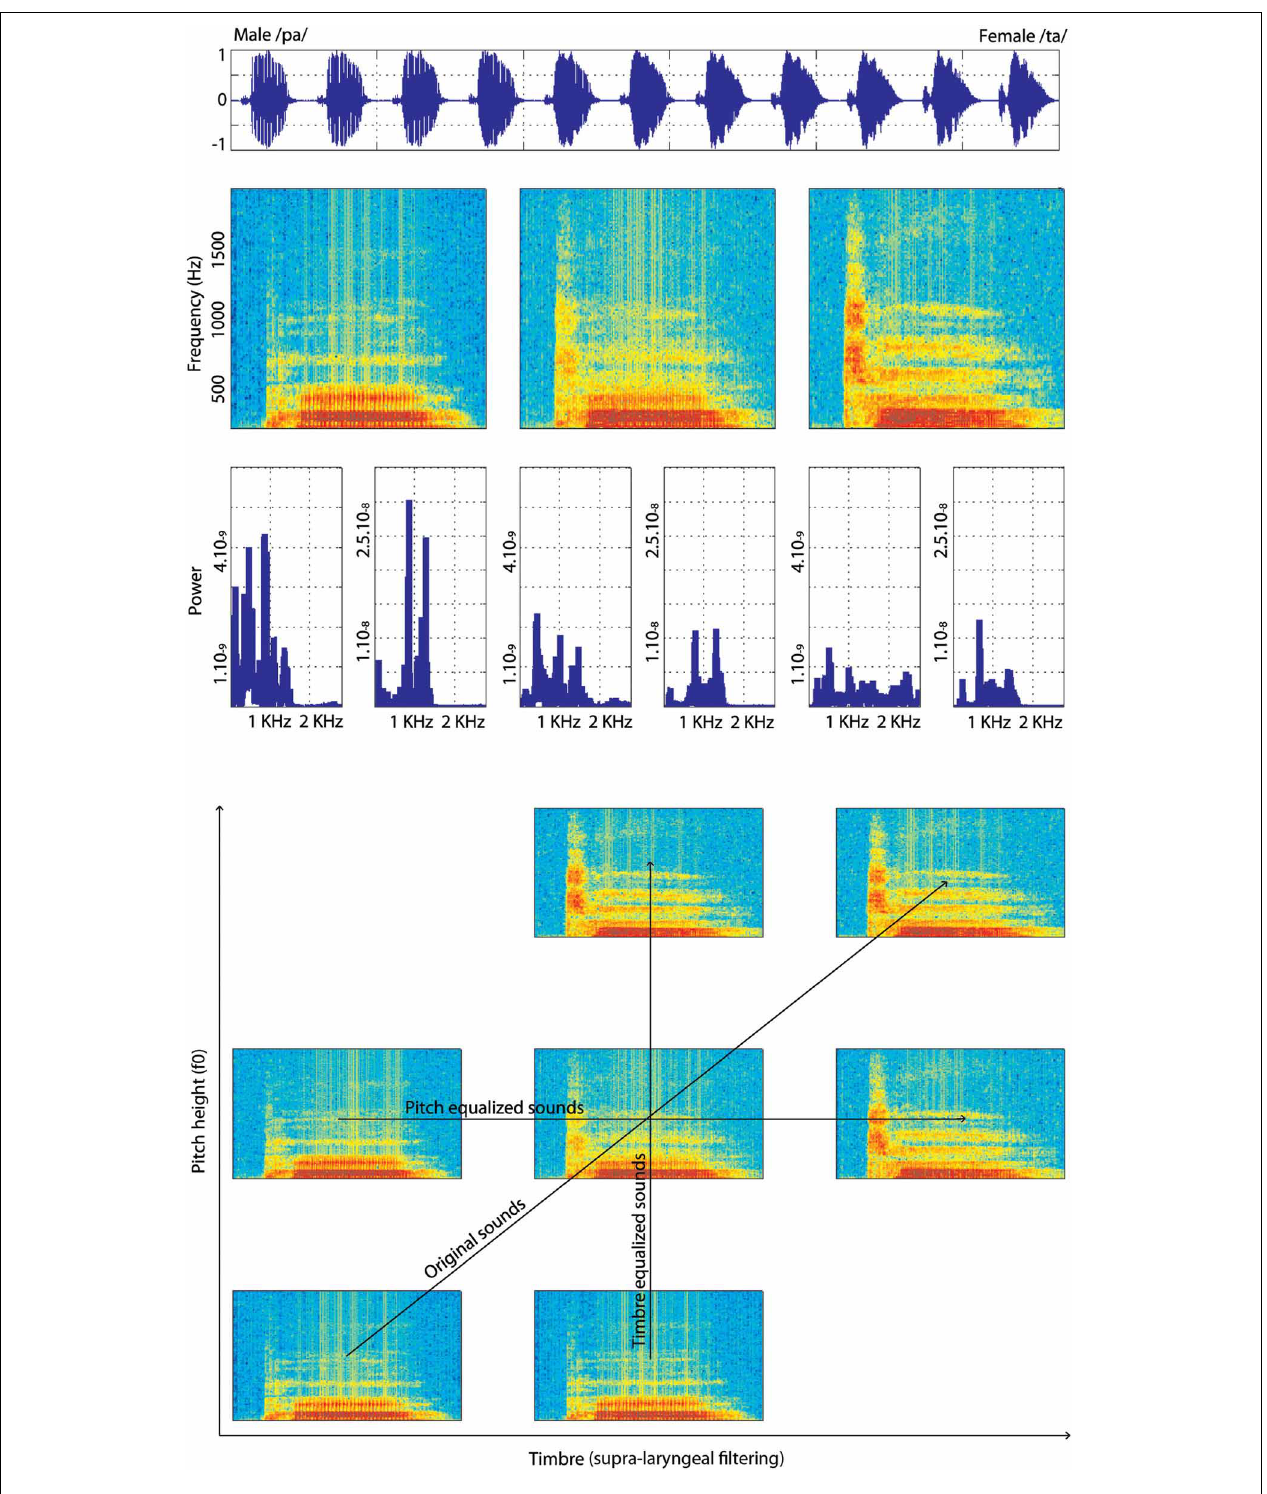
FIGURE 1 | Illustration of one continuum of male-/pa/ to female-/ta/. At the top is presented a male-/pa/ to female-/ta/ continuum in the time domain (waveforms). Below it, the time-frequency domain (spectrograms with hamming window, sampling at 22,040Hz) of the 100% male-/pa/ stimulus, 50% male-/pa/, 50% female-/ta/ stimulus and 100% female-/ta/ stimulus from